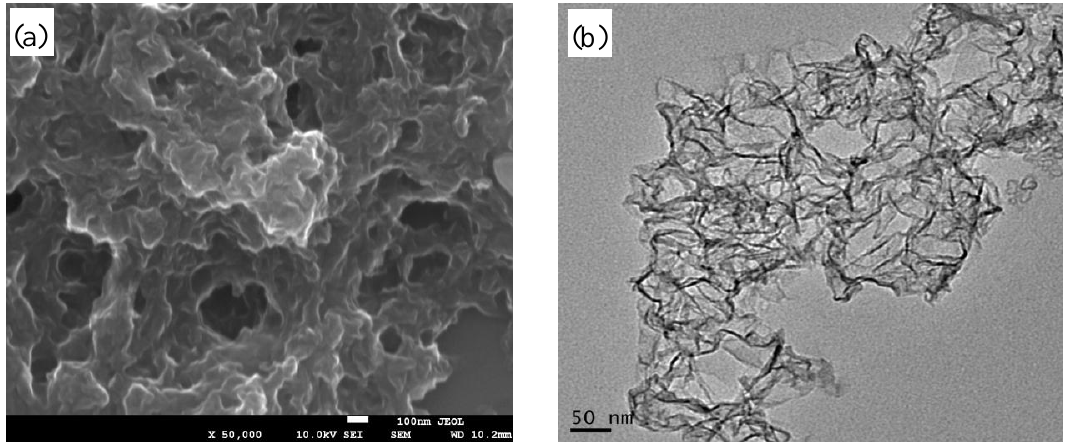
Figure 2. Morphology of FG prepared via facile solvothermal route: ( a ) FE-SEM image; and ( b ) TEM